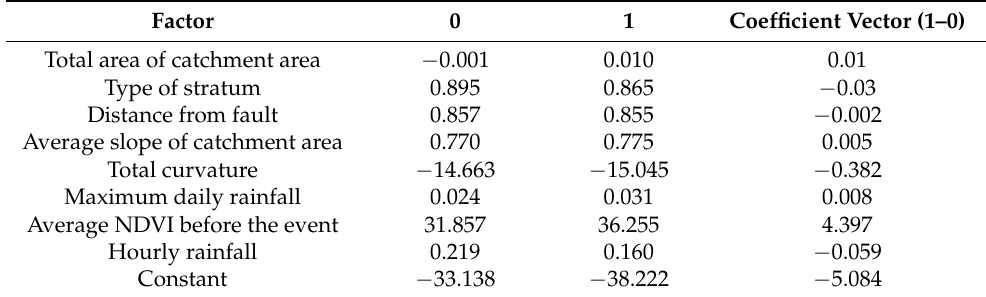
Table 12. Coefficients of Fisher’s discriminant classification function.